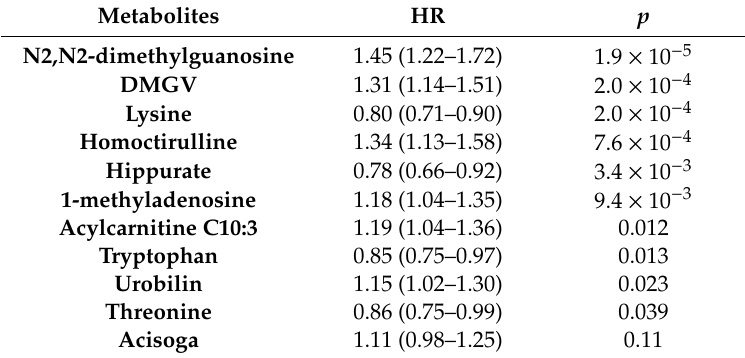
Associations between plasma levels metabolites and all-cause mortality in participants with diabetes from the Malmö Diet and Cancer-Cardiovascular Cohort (MDC-CC) ( n = 374) and the Malmö Preventive project (MPP) ( n = 369). The hazard ratios (HR) were calculated separately in MDC-CC and MPP from cox regression models (adjusted for age, sex, BMI, Systolic blood pressure, antihypertensive treatment, smoking status and fasting levels of glucose, HDL cholesterol, LDL cholesterol and triglycerides) and subsequently meta-analyzed using inverse variance-weighted meta-analysis, using fixed estimates. The HR of all-cause mortality is expressed per